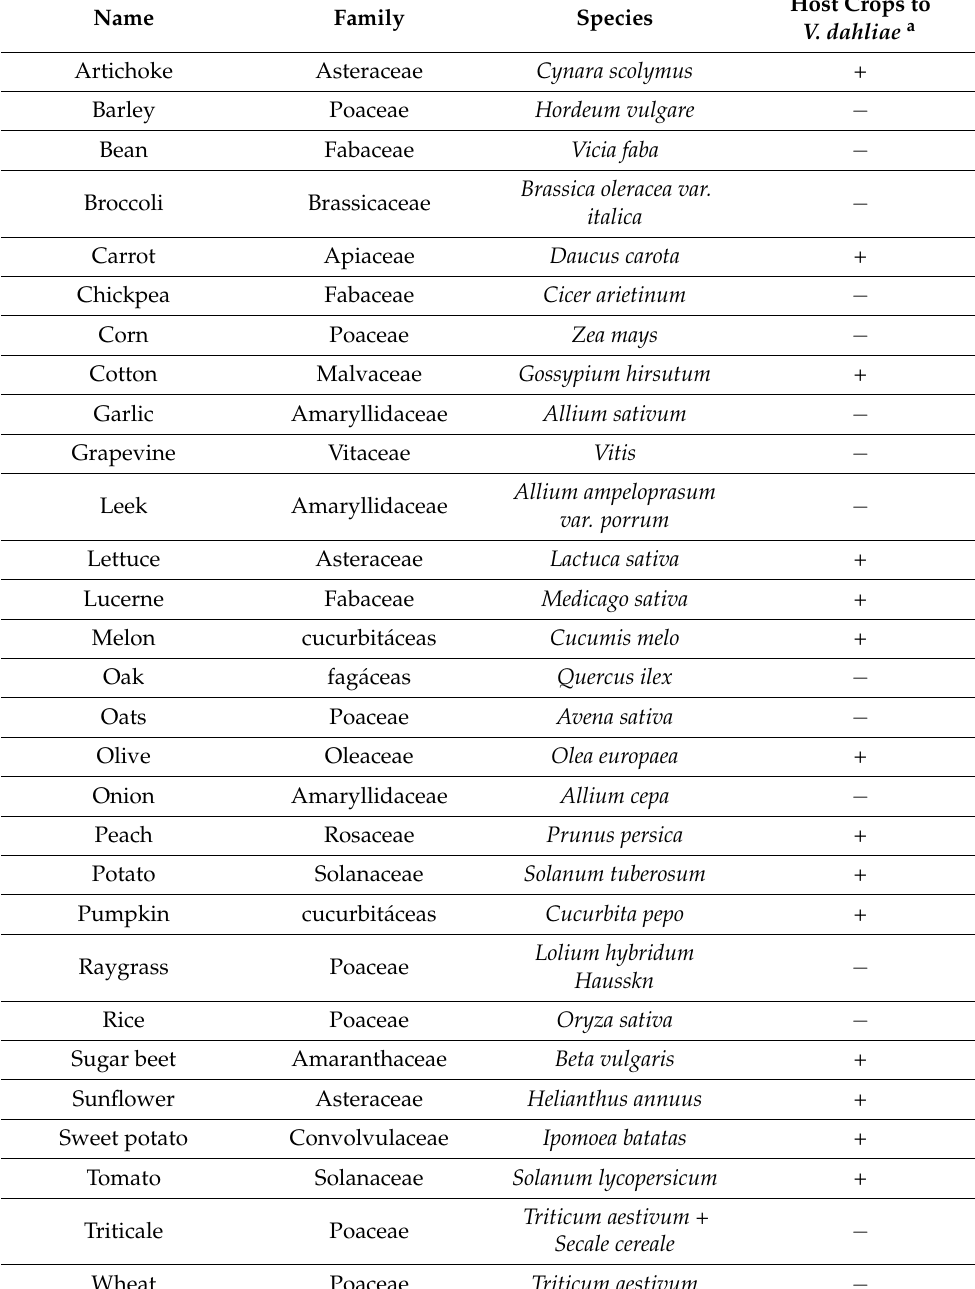
Table 1. Plant species cropped in sampled fields in the five years before soil